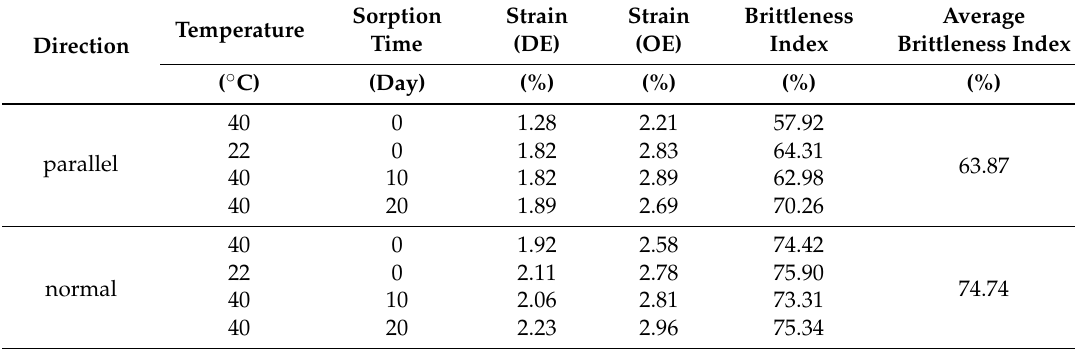
Table 2. Brittleness determination from stress-strain curves for all